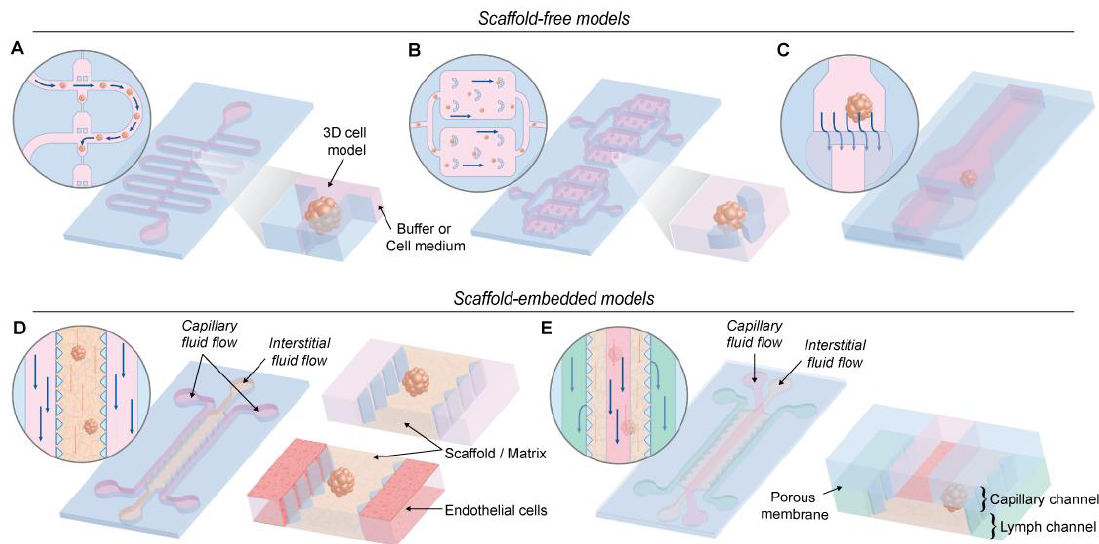
Figure 8. Schematic representation di ff erent microfluidic devices used. ( A ) A device containing a sinuous microchannel each of which contains five microwells for sedimentation trapping of the loaded microtissues or spheroids [127]. ( B ) A device containing permanent U-shaped microstructures. The flow of culture medium towards the microstructure pushes the cells inside [125]. ( C ) A two-layer microfluidic chip. The spheroid is immobilized in the higher part of the channel before the dam, where the height decreases from 250 to 25 µ m [129]. ( D ) These devices consist of 2 media channels engulfing an extended, central region containing the sca ff old / matrix. The devices contain an array of trapezoidal posts that cage the matrix solution into well-defined regions with uniform surface interface. The side channels can be perfused with endothelial cells to simulate the endothelial wall [130,132]. ( E ) Microfluidic platform with three types of channels - capillary, interstitial and lymphatic channels (noted with red, yellow and red colors). These channels are independently pressurized to mimic the elevated interstitial fluid pressure and are configured in a 3D structure by stacking two polydimethylsiloxane (PDMS) layers of microchannels with a porous membrane sandwiched between the layers [123].